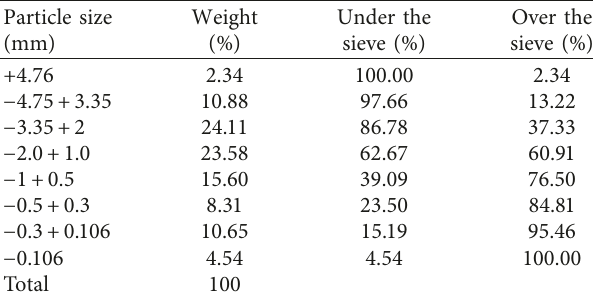
Table 4: Sample-C1 screen analysis